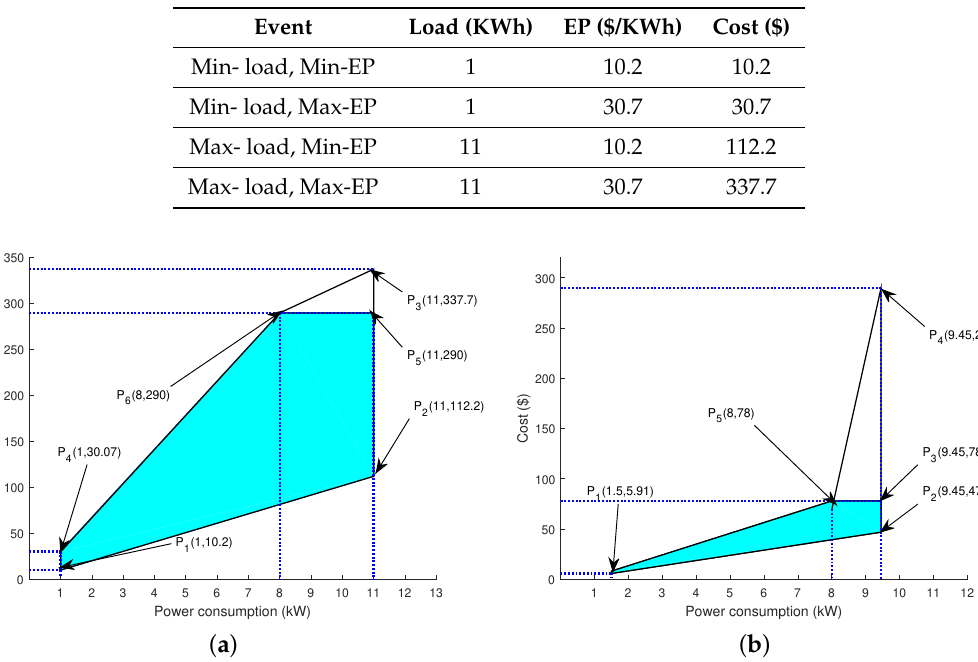
Figure 6. Feasible region for scheduled load with: ( a ) feasible region for scheduled load with RTP, and ( b ) feasible region for scheduled load with